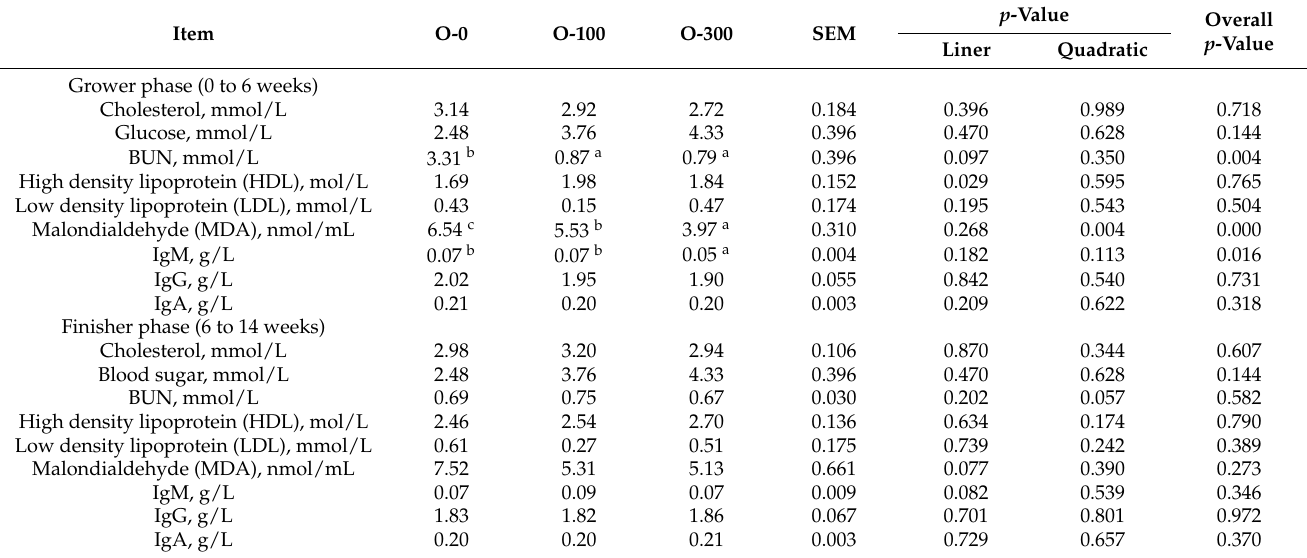
Table 4. The effect of LL supplementation on the hematological parameters of growing and finishing